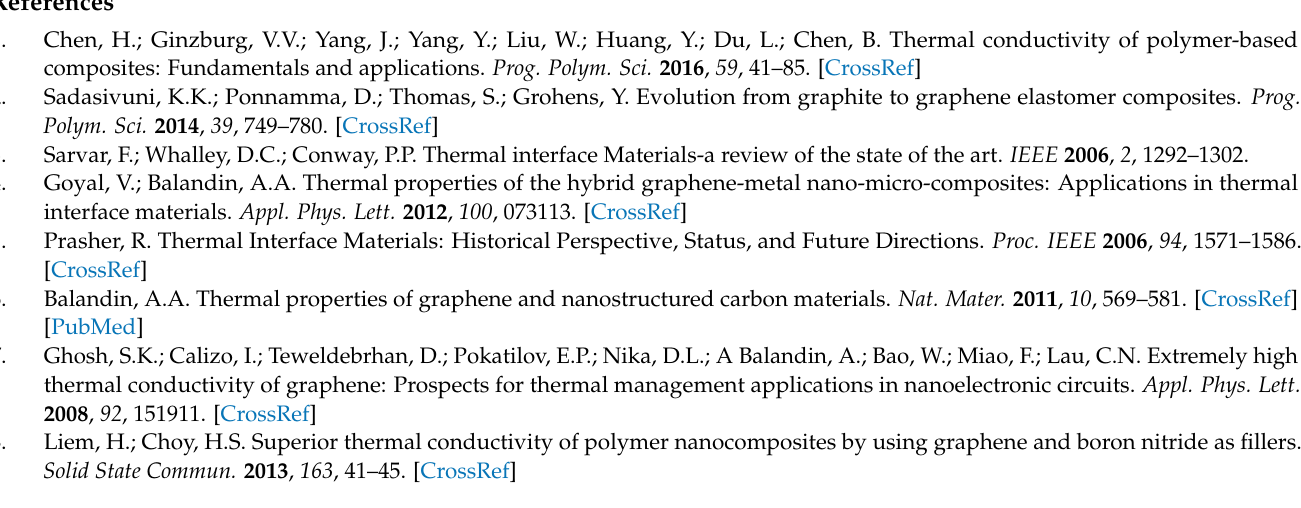
Figure S2: SEM images of the(a) GF, (b) GF/PPD, (c) GF/PANI 4:1 , (d) GF@EP, (e) GF/PPD@EP and (f)